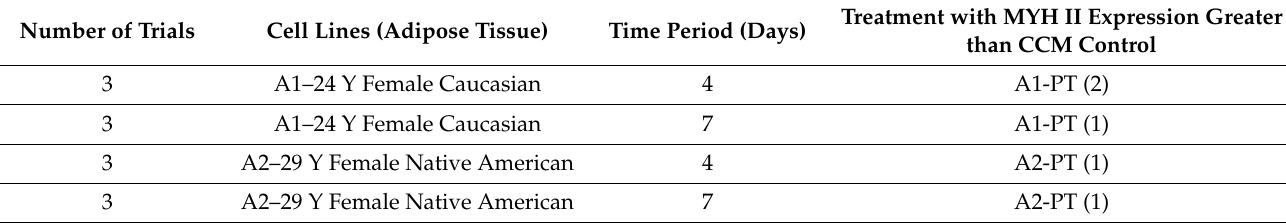
Figure 4. Comprehensive flow cytometry data from human bone marrow (hBM)-MSC cell lines subjected to different DM treatments and time points (n = 3 per cell-line/growth-factor treatment/timepoint) and analysis of MYH II expression. The treatments without primary antibody addition are considered secondary controls. The differences between the treatments were not statistically significant. Each data point was obtained based on the measurement of 20,000 events in FACS CANTO II. Table 2. Application of PDGF + TGF β 1 (PT) growth factor induced DM treatments to two adipose-derived cell lines (A1, A2) for a time point of four and seven days, respectively. PT (semi-batch) treatment could elicit MYH II expression greater than CCM control in at least one trial in all cases.